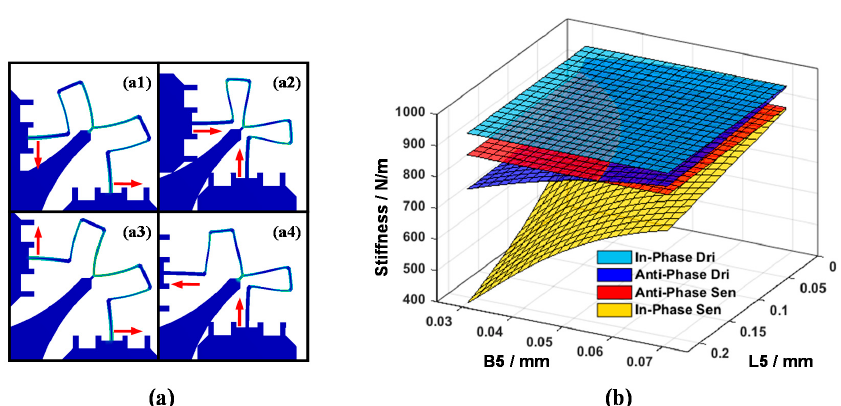
Figure 9. ( a ) The colored elastic strain patterns of Y-shaped coulping beam under anti-phase drive mode ( a1 ); anti-phase sense mode ( a2 ); in-phase drive mode ( a3 ); and in-phase sense mode ( a4 ); ( b ) The relationship of the Y-shaped beam geometric parameters and four main mode stiffness.